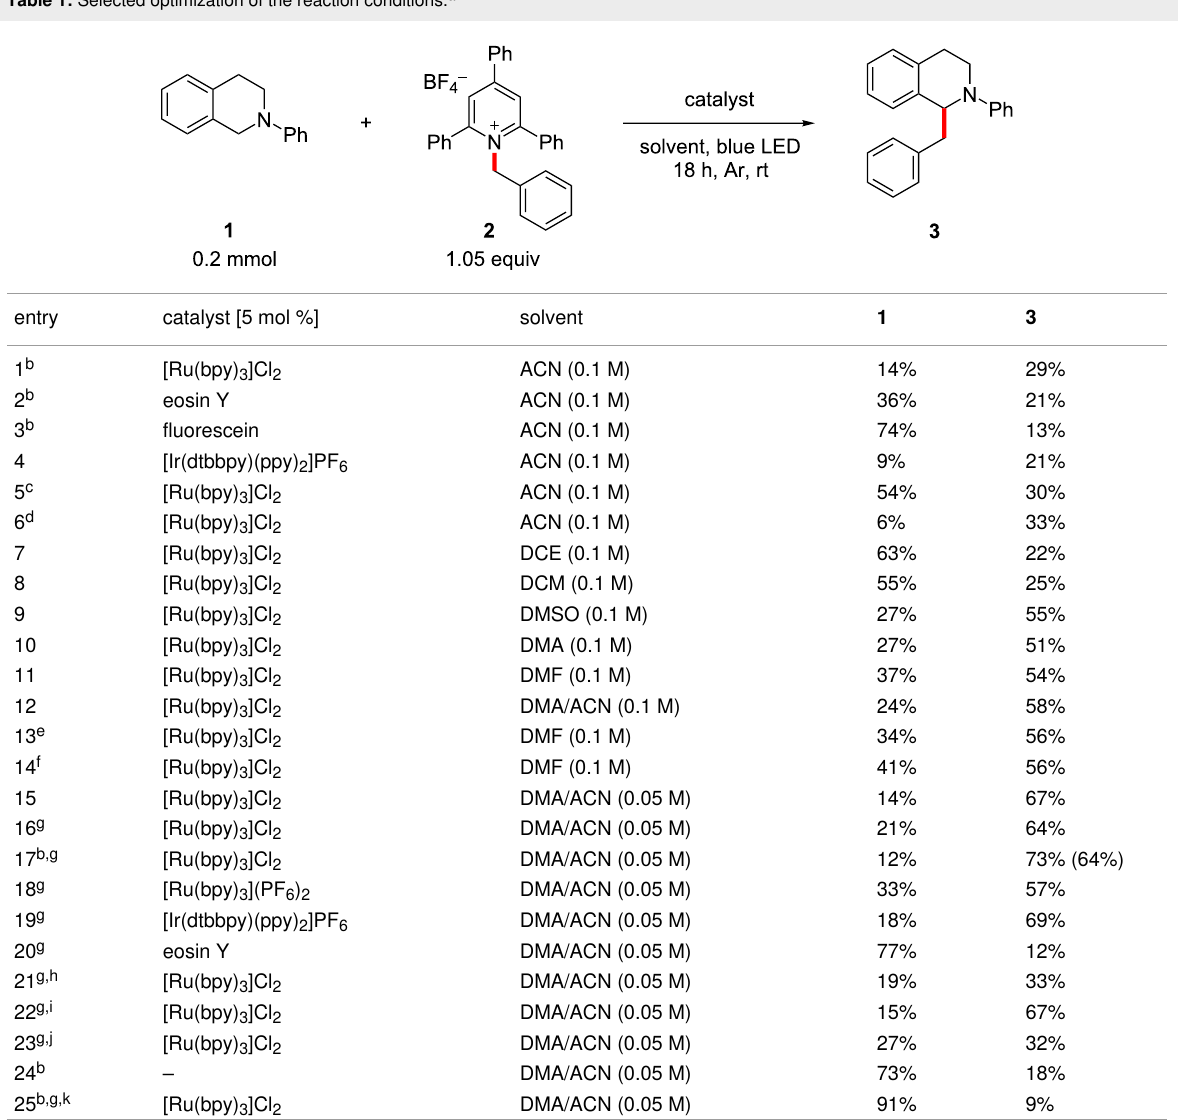
Table 1: Selected optimization of the reaction conditions.